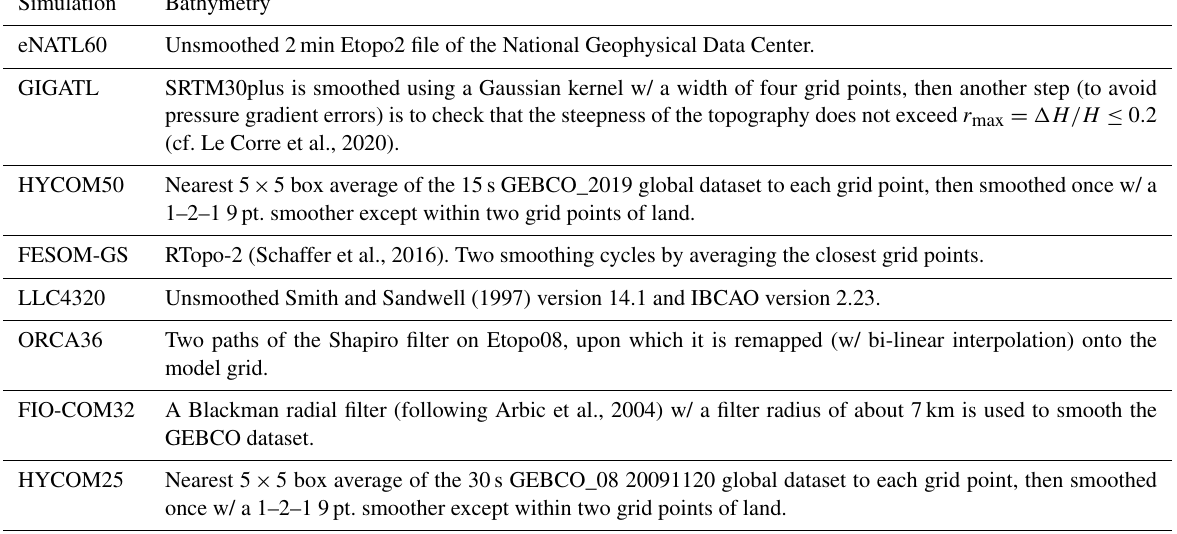
Table B4. The bathymetry configuration of each simulation.